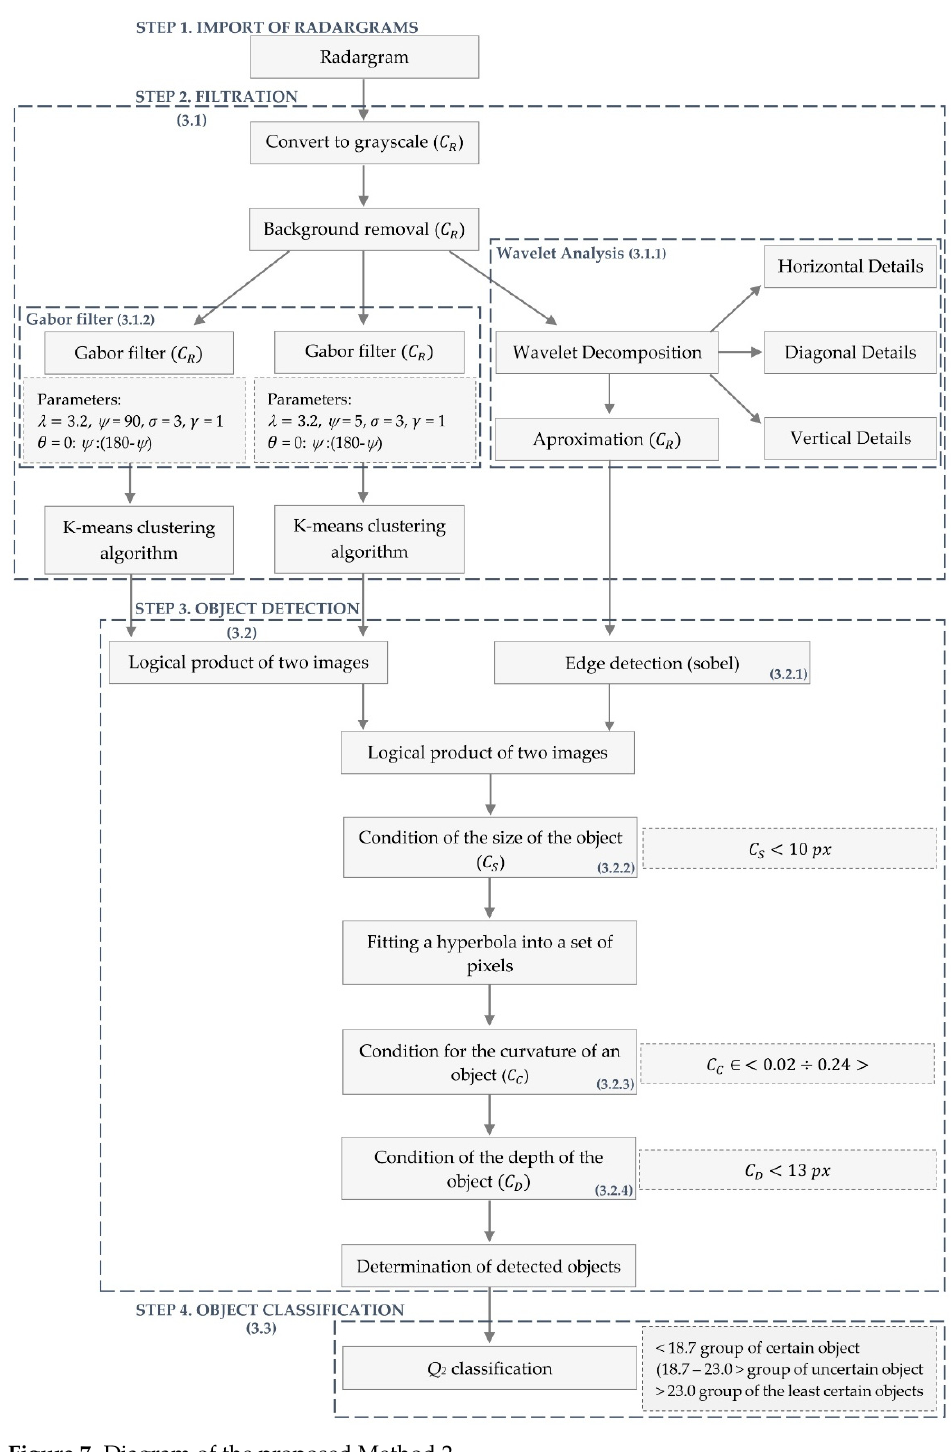
Figure 7. Diagram of the proposed Method 2.